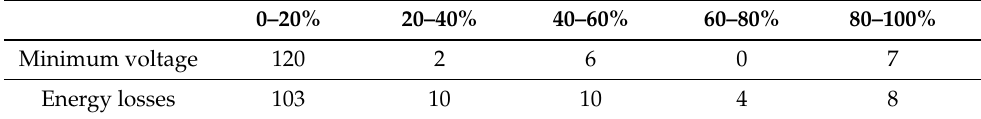
Table 10. AMD of the values obtained (20% variation in demand).